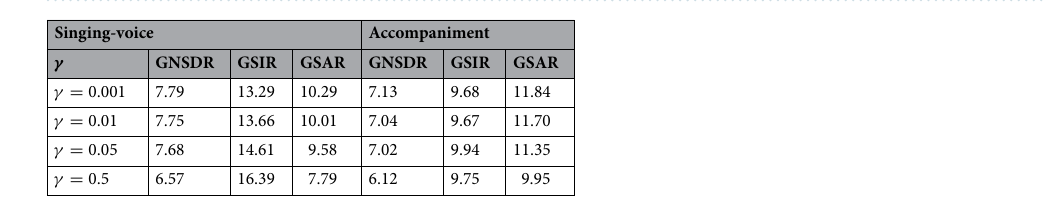
Table 2. The influence of parameter γ on separation